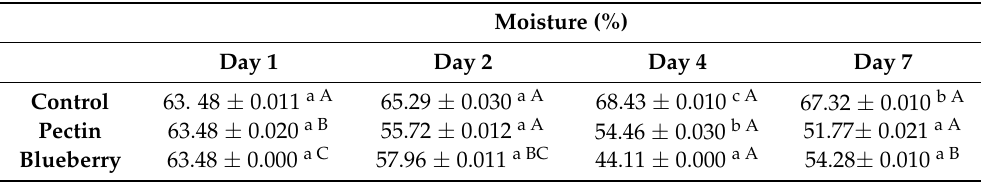
Table 5. Moisture (%) of salmon fillets during storage with different